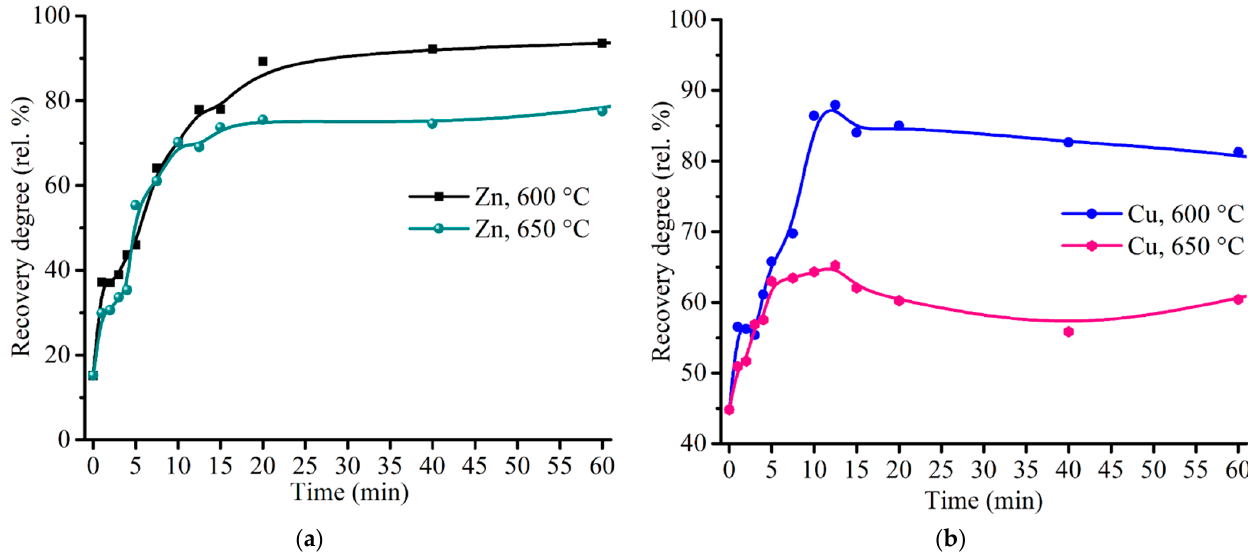
Figure 12. Effect of roasting time on the recovery degree of zinc ( a ) and copper ( b ) at 600 and 650 °C with the addition of 48% Fe 2 (SO 4 ) 3 ∙ 9H 2 O to 100% ZPR and subsequent water leaching.